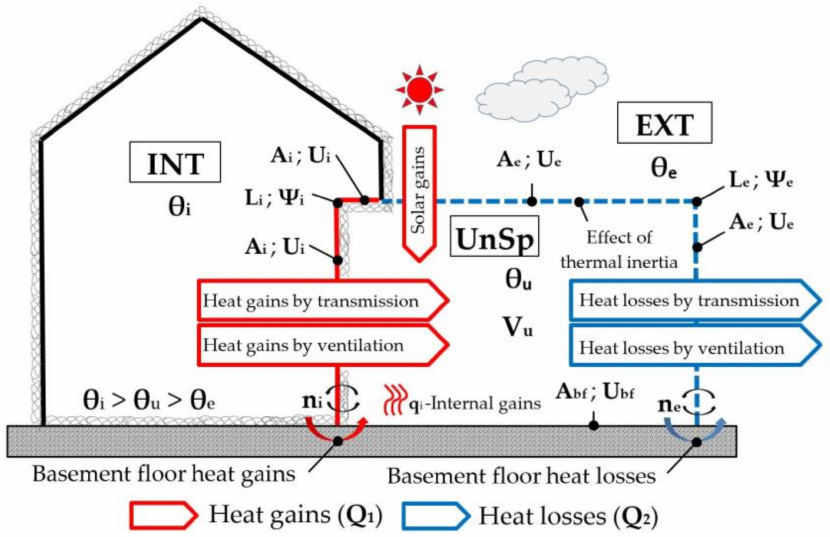
Figure 1. Schematic representation of heat exchanges in an UnSp. Notation used in Figure